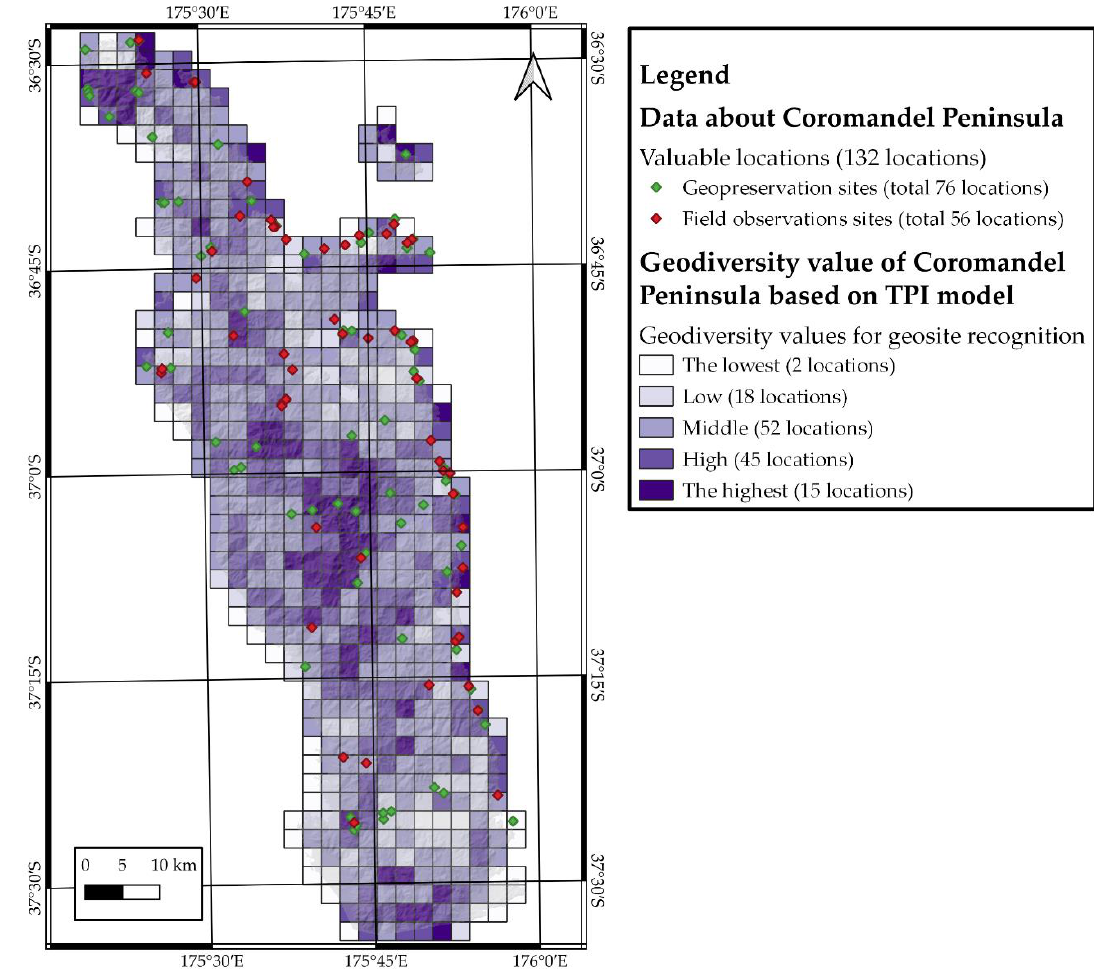
accessed on 28 August 2022 and https://naturemaps.nz/maps/#/viewer/openlayers/484, accessed on